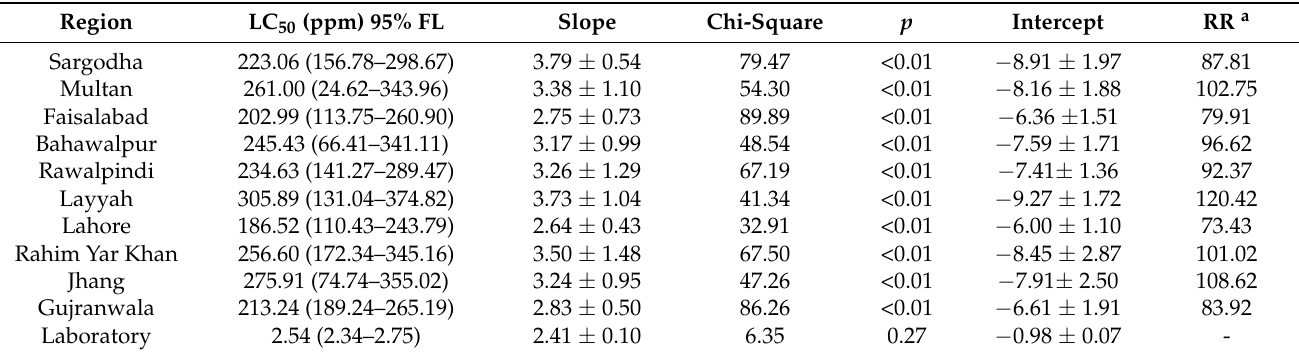
Table 3. Probit analysis of mortality for 10 field-collected populations and a laboratory-susceptible population of Tribolium castaneum adults after 20 h of exposure to phosphine. In all cases DF = 5. Region LC 50 (ppm) 95% FL